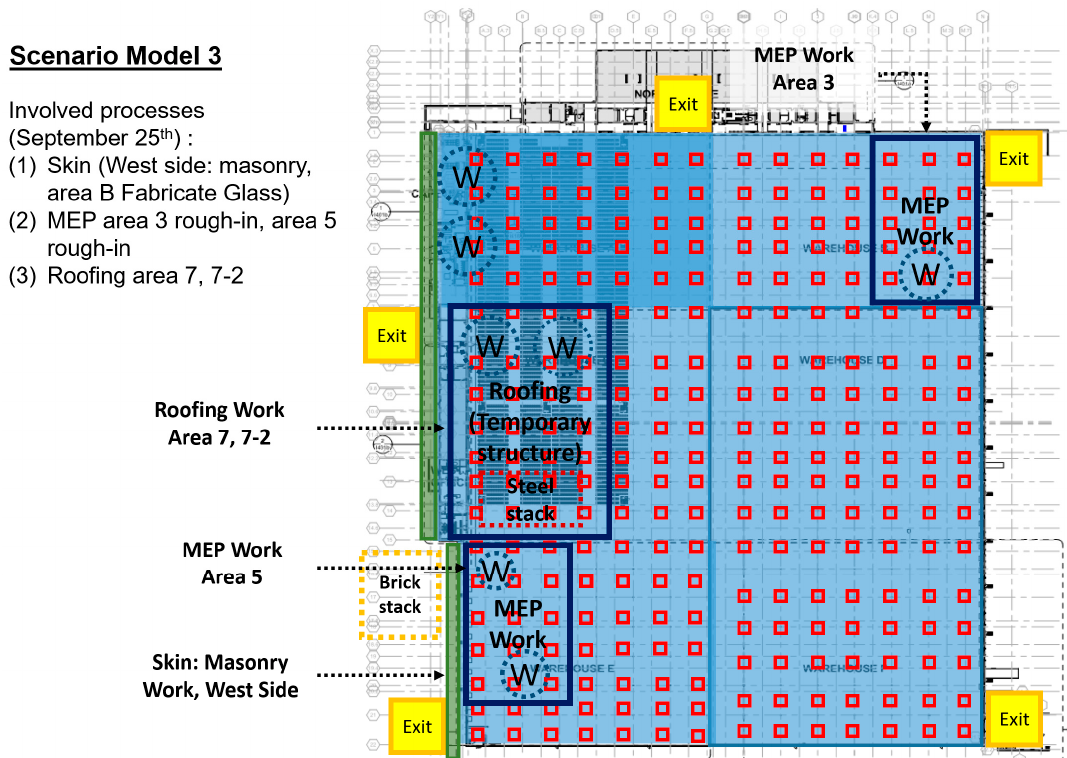
Figure 8. Scenario Model 3: Work status and site conditions.